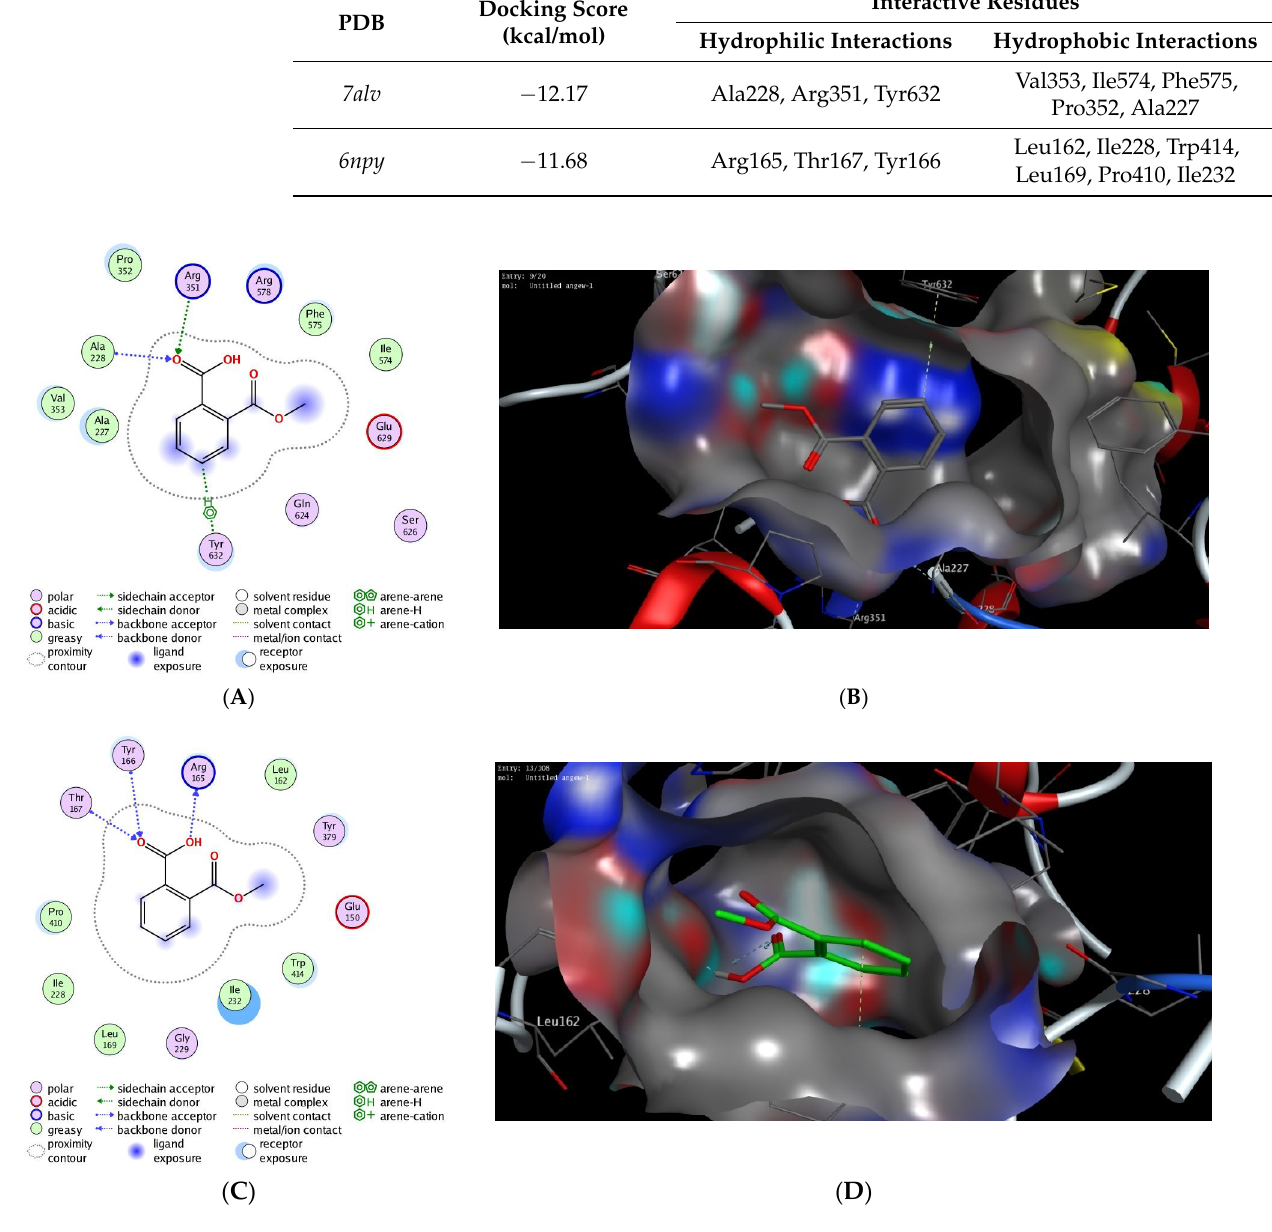
Figure 7. The 2D and 3D molecular modelling interactions of ASA (green and grey in 3D interactions) with NLRP3 protein: 7alv ( A , B ), and 6npy ( C , D ). Dotted green arrows represent the hydrogen bonds; (C atoms are colored green, S yellow and O red).